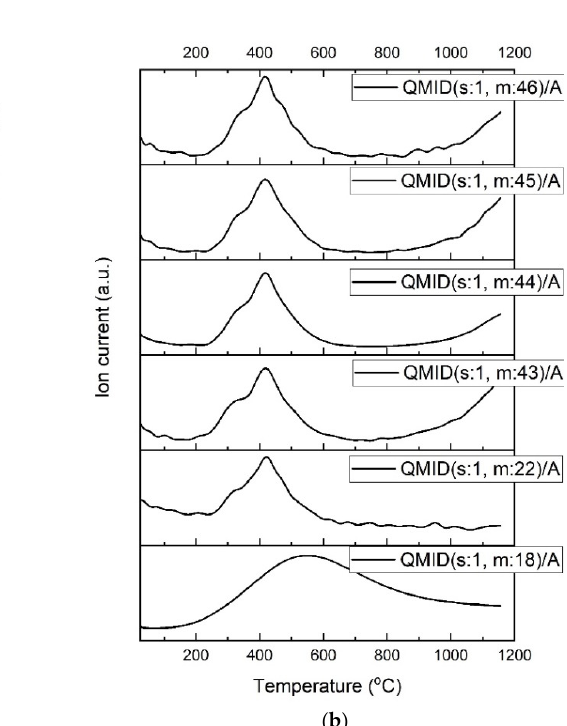
Figure 10. EGA results for Diesel engine, where ( a ) presents DSC-TG signals, and ( b ) shows QMS registered signals.